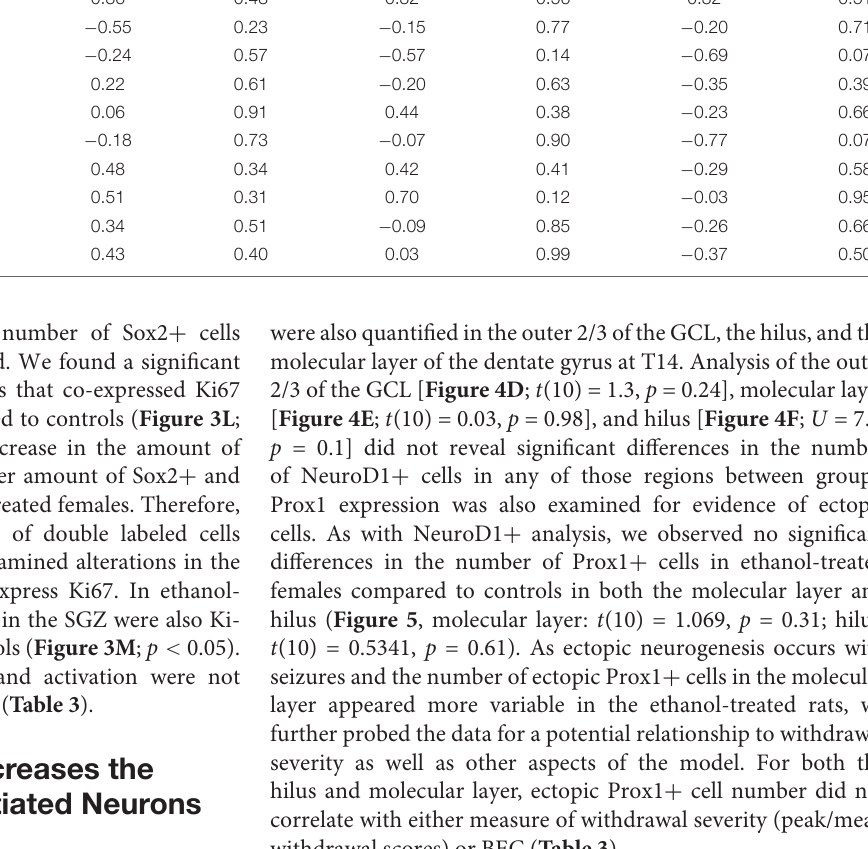
t (10) = 0.5341, p = 0.61). As ectopic neurogenesis occurs